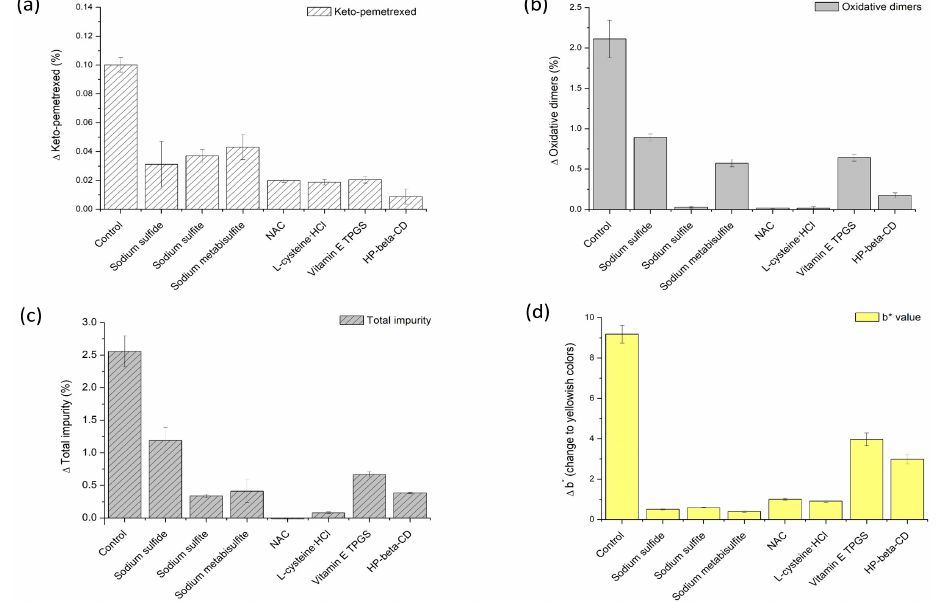
Figure 2. E ff ect of antioxidants on pemetrexed degradation induced by stress condition at 60 ◦ C in aqueous solution: ( a ) increase in keto-metotrexed content; ( b ) increase in oxidative dimer content; ( c ) increase in total impurity content; and ( d ) increase in b* value as an indicator of color change to